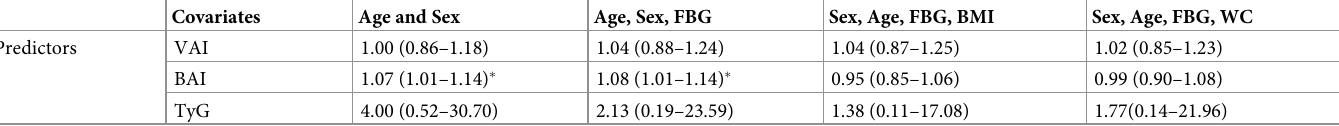
Table 2. AUC used to evaluate the goodness of fit in logistic regression in different models.